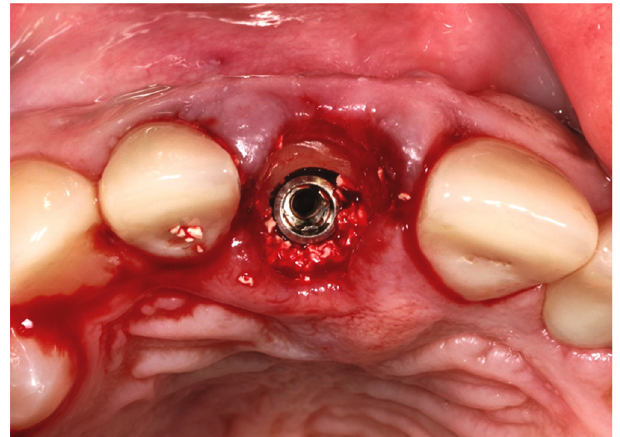
Figure 9: The implant in place — socket shield can be observed buccally along with some xenograft material.